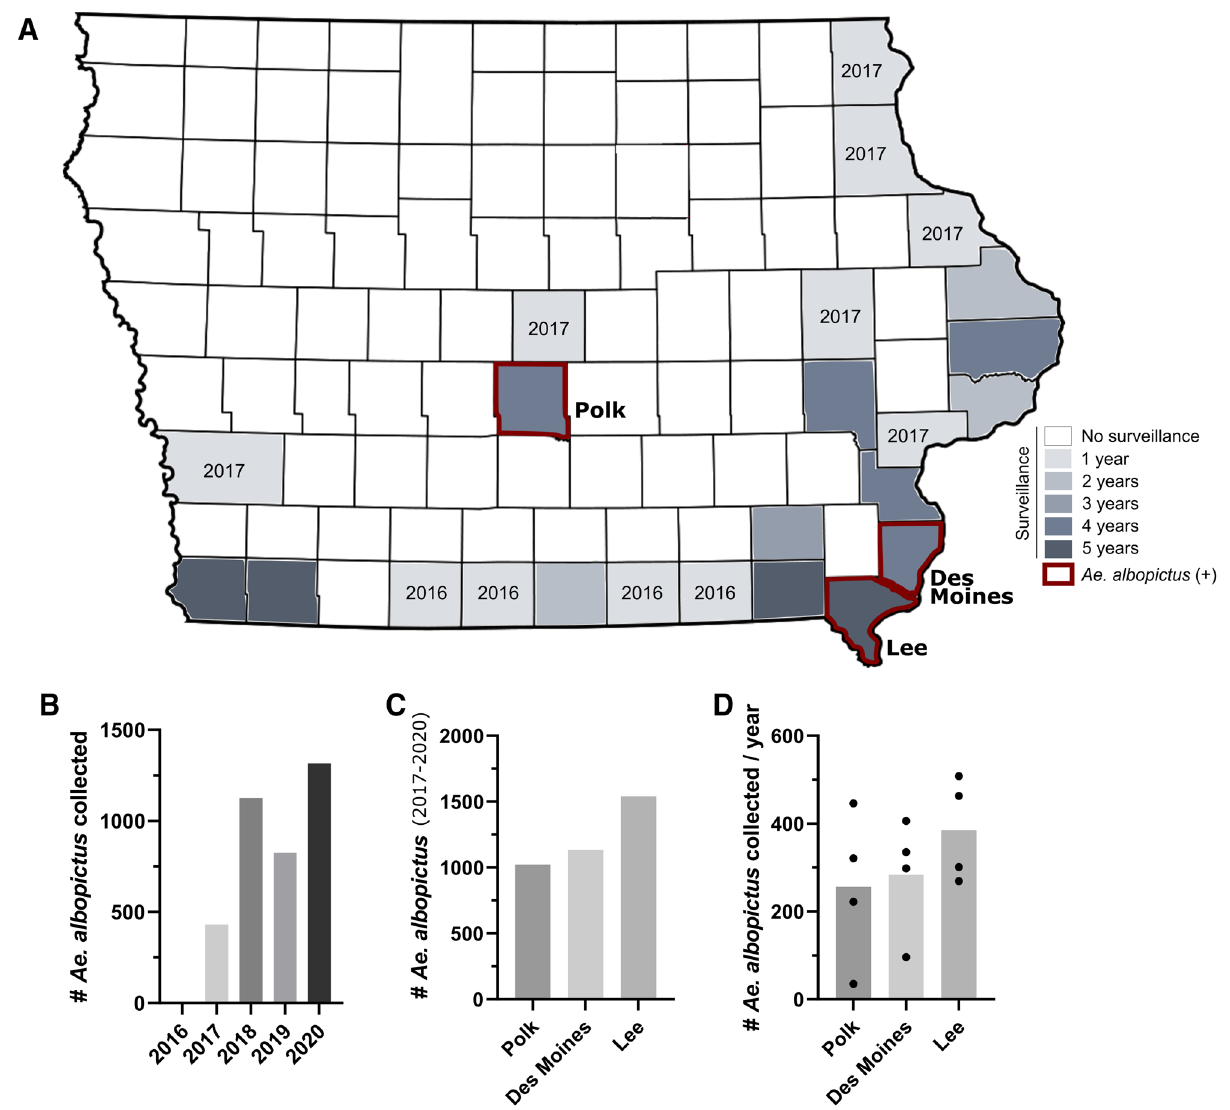
Figure 1. Overview of mosquito trapping locations and number of Ae. albopictus collected in Iowa (2016– 2020). Mosquito surveillance efforts targeting invasive Aedes species were performed in a total of 25 Iowa counties from 2016 to 2020 ( A ). Participating counties were shaded based on the number of years trapping efforts were performed in that county, with years listed when a county was included in trapping efforts for only a single year. Counties in which Ae. albopictus were detected are outlined in red. The number of Ae. albopictus collected are displayed for each year ( B ), in each Ae. albopictus -positive county ( C ), and average number collected per year in each county ( D